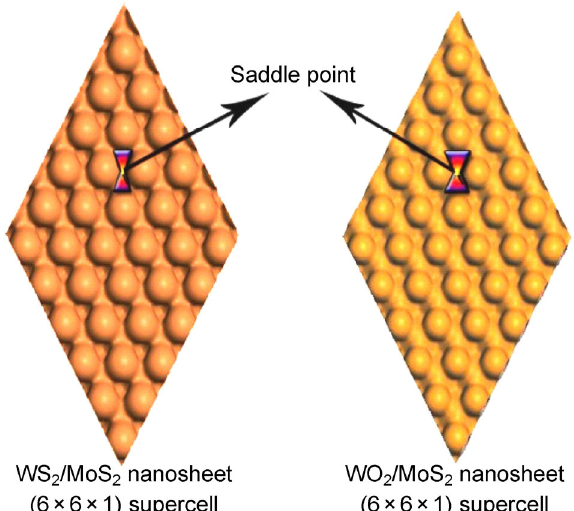
Fig. 5 Topography of the electron distribution of the single layer transition metal disulfide and dioxide nanostructures.